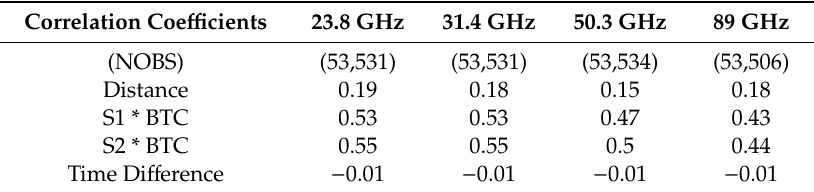
Table 4. Correlation coe ffi cients between ∆ TB and related